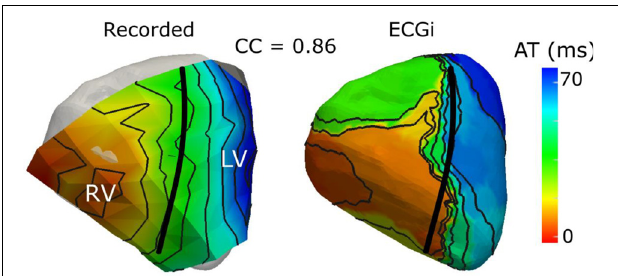
FIGURE 5 | Validation of ECGI derived activation maps using an ex vivo torso tank set up has demonstrated that, in electrical dyssynchrony, ECGi (right) produces a “line of activation block” that is not present in recorded signals (left) using an epicardial electrode sock [adapted with permission from Bear et al.